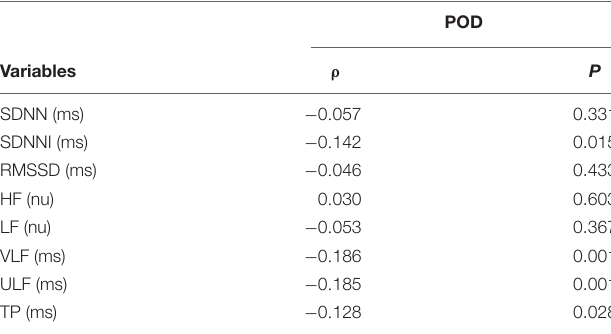
TABLE 3 | Spearman’s correlation coefficients between HRV parameters and